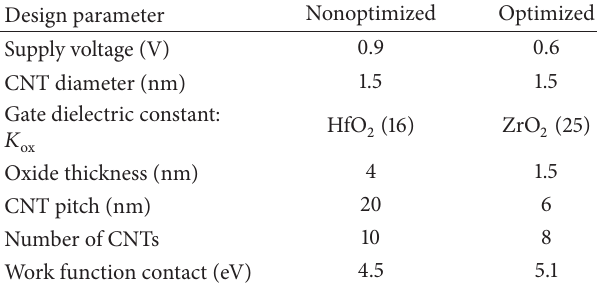
Table 3: List of design parameters for nonoptimized and optimized CNFET.